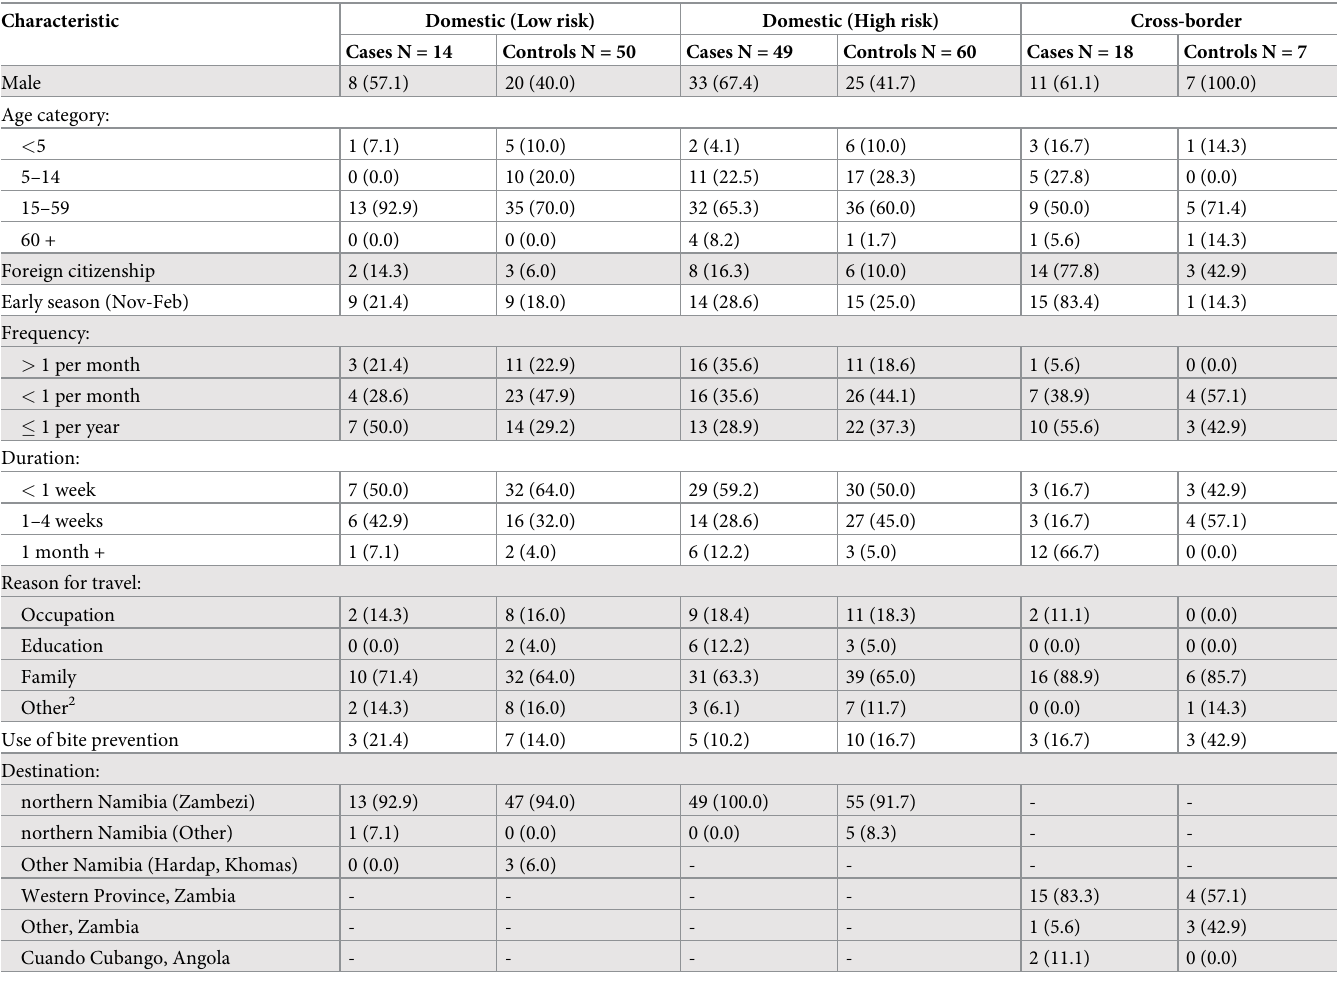
Table 2. Travel characteristics of cases and controls reporting overnight travel in prior 30 days 1 , from a sample of 770 cases and 641 controls in Zambezi